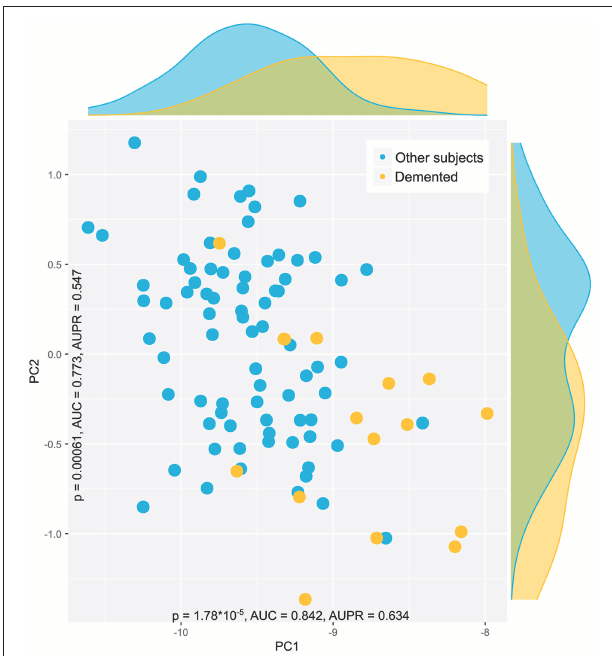
FIGURE 4 | Data structure found in the input space of d = 35 lipid mediator plasma concentration acquired from patients with dementia (yellow dots) or from patients with either bipolar disorder, depression, ADHD, or enrolled as healthy controls (blue dots). The data structure has been obtained by means of principal component analysis on the log-transformed data as suggested by the results of the PC-corr analysis ( 39). The PCA plot associated to this analysis shows the sample separation in the first and second component (PC1 vs. PC2) as explaining most of the variance in the data. In addition, the group-wise marginal distributions of the data are shown. The figure has been created using the R software package [version 3.4.4 for Linux; http://CRAN.R- project.org/; ( 13)] and the library “ggplot2” [https://cran.r-project.org/ package=ggplot2; (